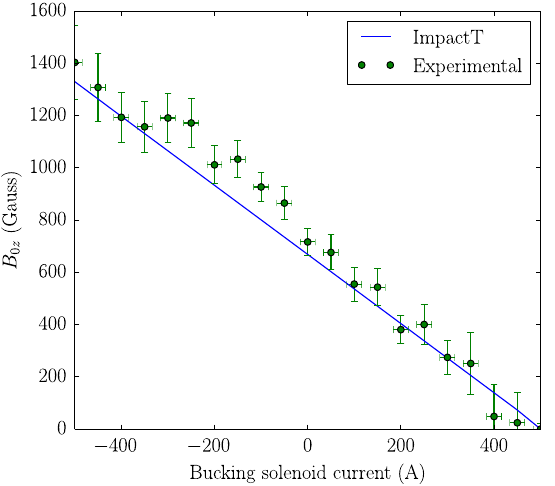
FIG. 13. Comparison between IMPACT - T simulations (solid blue line) and experimentally recovered values of B 0 z (symbols with error